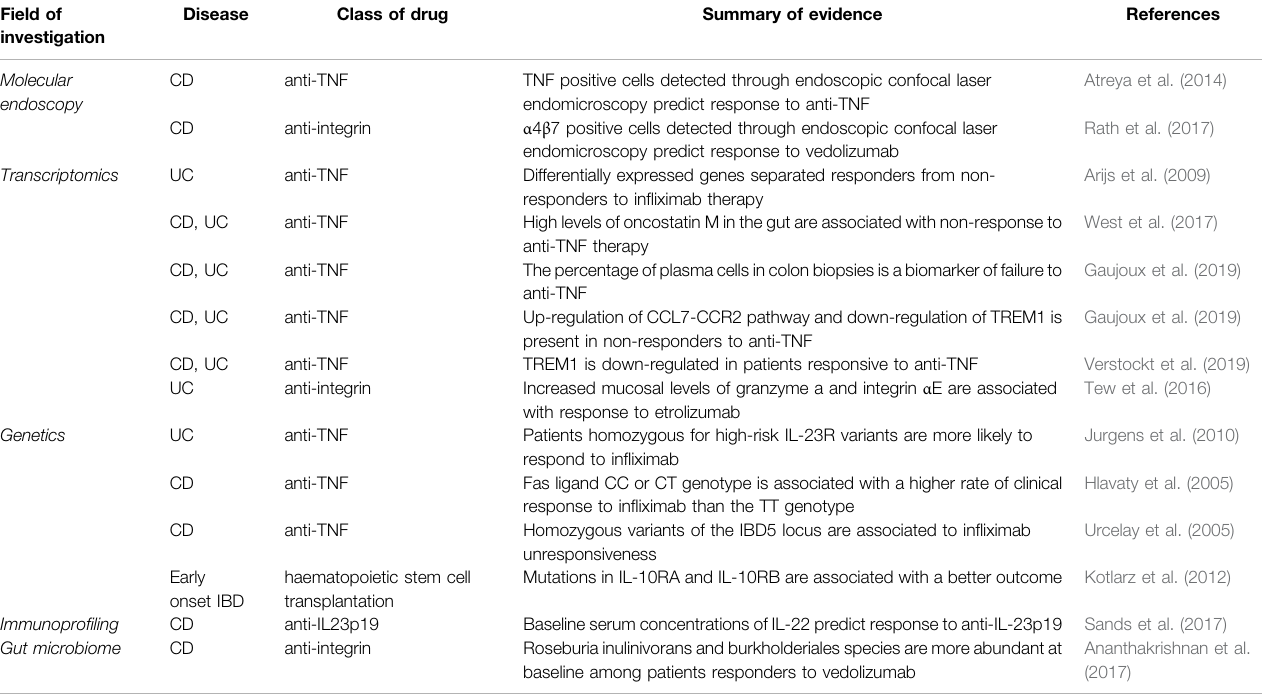
TABLE 1 | Summary of the current evidence on precision medicine in